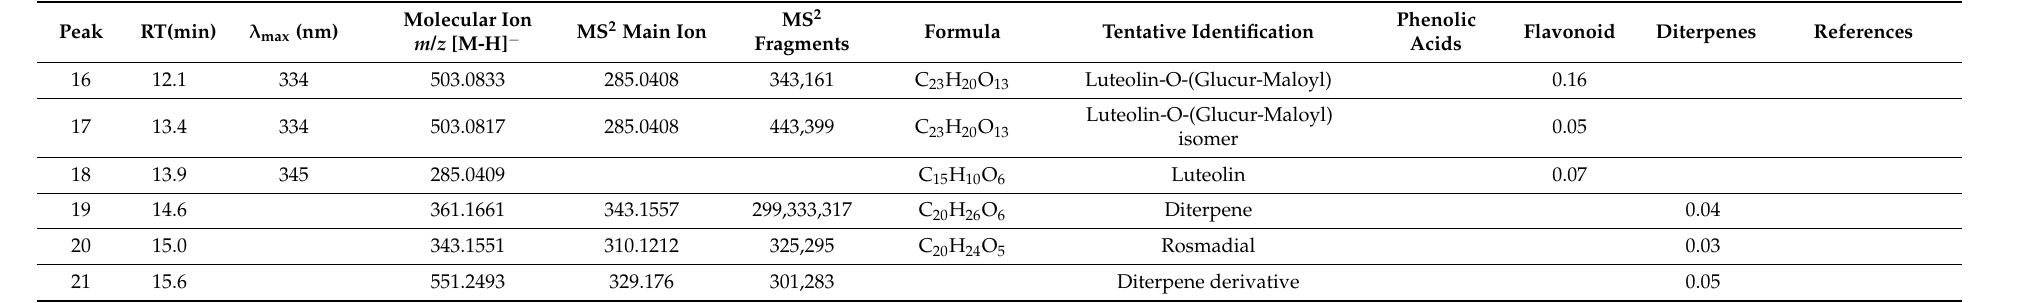
Table 2. Phytochemical components present in Coleus amboinicus Lour. cultivated in Indonesia (CI1 and CI2) and in Poland (CPL, CPF, CPS, CPT) (mg · 1 g − 1 Extract, n = 3, mean value ± SD, as gallic acid equivalents (for total phenols), carnosic acid equivalents (for diterpenoids), rosmarinic acid equivalents (for phenol carboxylic acids) and isoquercitrin equivalents (for flavonoids) based on UHPLC − MS data.